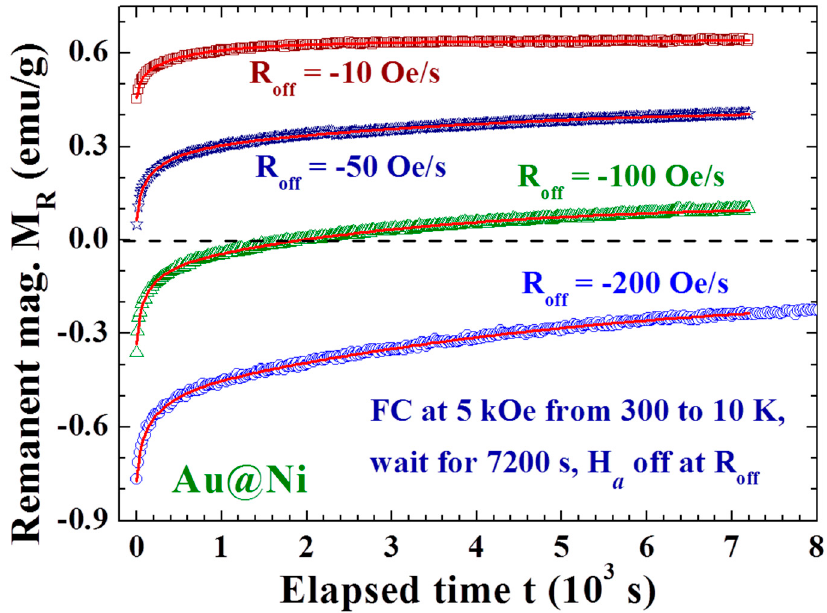
Figure 3. Time evolution of the remanent magnetization M R recorded after field-cooling at H a = 5 kOe from 300 to 10 K, followed by a 7200 s wait before turning the H a off at rates of R off = − 200 Oe/s (open circles), − 100 Oe/s (open triangles), − 50 Oe/s (open stars), and − 10 Oe/s (open squares). Spontaneous increases in the magnitude of M R are seen in the R 0ff = − 50 and − 10 Oe/s curves. A spontaneous reversal in the direction of M R appears in the R off = − 100 Oe/s curve.